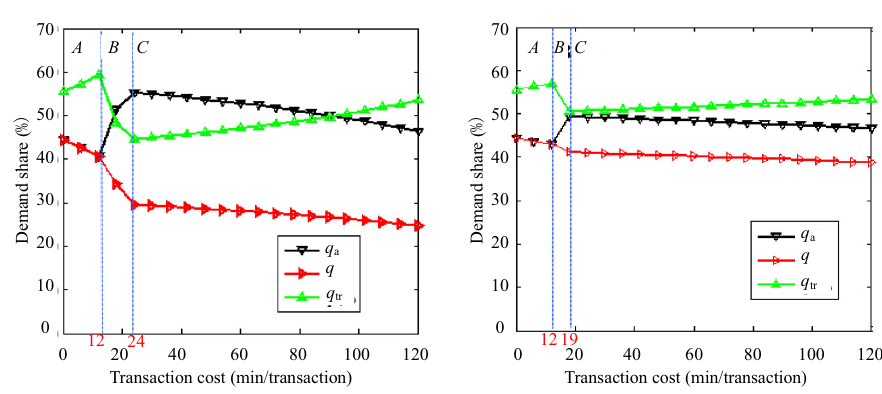
(cid:9) 100 % ; q tr d